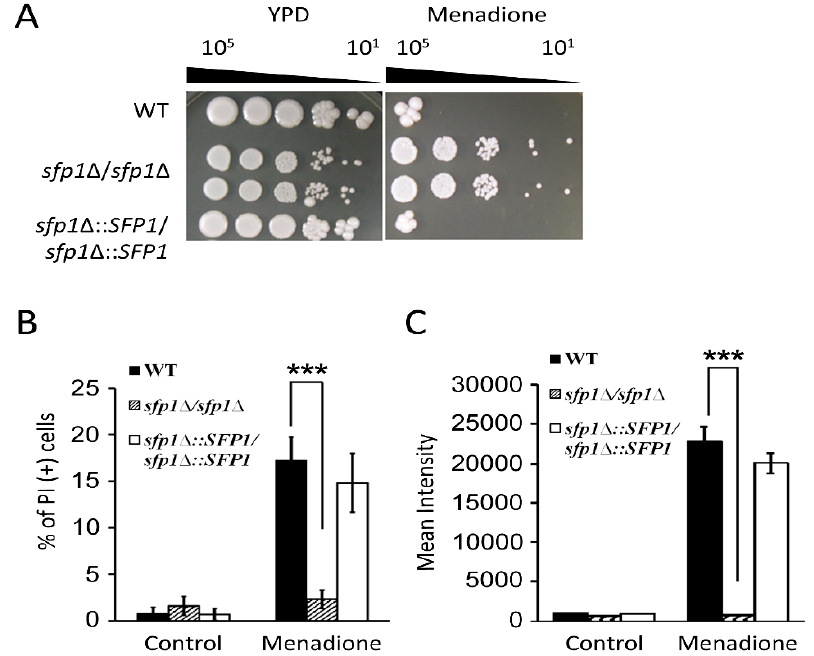
Figure 2. Susceptibility of C. albicans to menadione and menadione-induced intracellular ROS generation. ( A ) The cells were ten-fold serially diluted and spotted onto YPD agar plates with or without 290 µ M menadione. The agar plates were incubated at 30 ◦ C for 3–4 days. Representative images of three independent experiments with identical results are shown. ( B ) Cells were treated with 870 µ M menadione for 2 h, stained with 4 µ g / mL of PI, and analyzed using a flow cytometer. The dead cells are expressed as PI-positive cells. ( C ) Cells were treated with 290 µ M menadione for 2 h and stained with 20 µ g / mL H 2 DCFDA. The mean fluorescence intensity of 10,000 cells was determined by flow cytometry. The results are presented as the mean ± standard deviation (SD) of three independent experiments. *** P < 0.001.